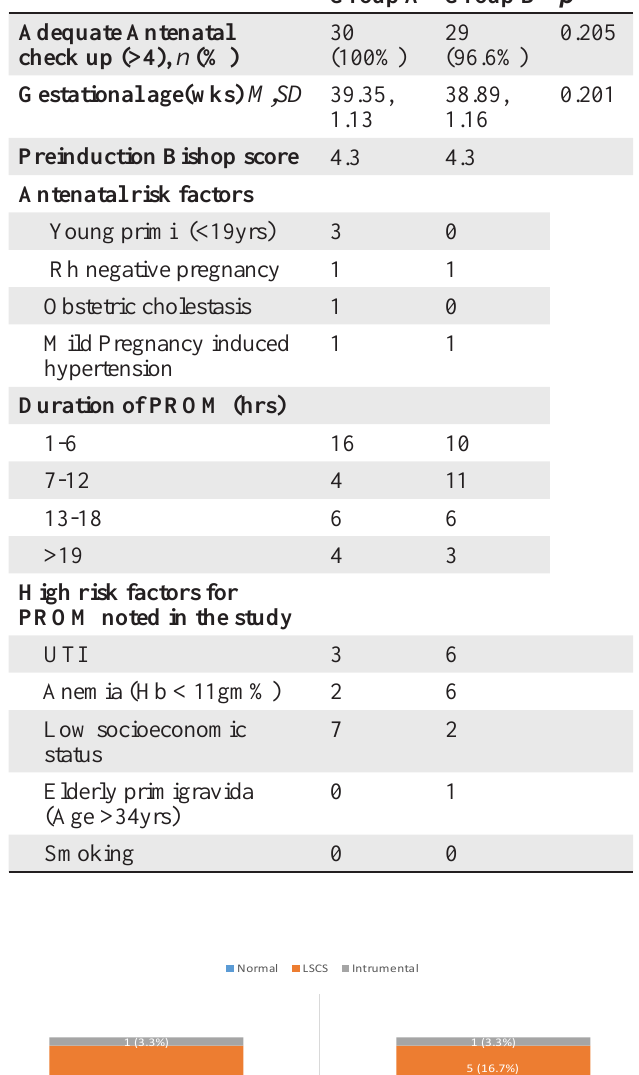
Table 2 : Distribution of cases according to antenatal parameters